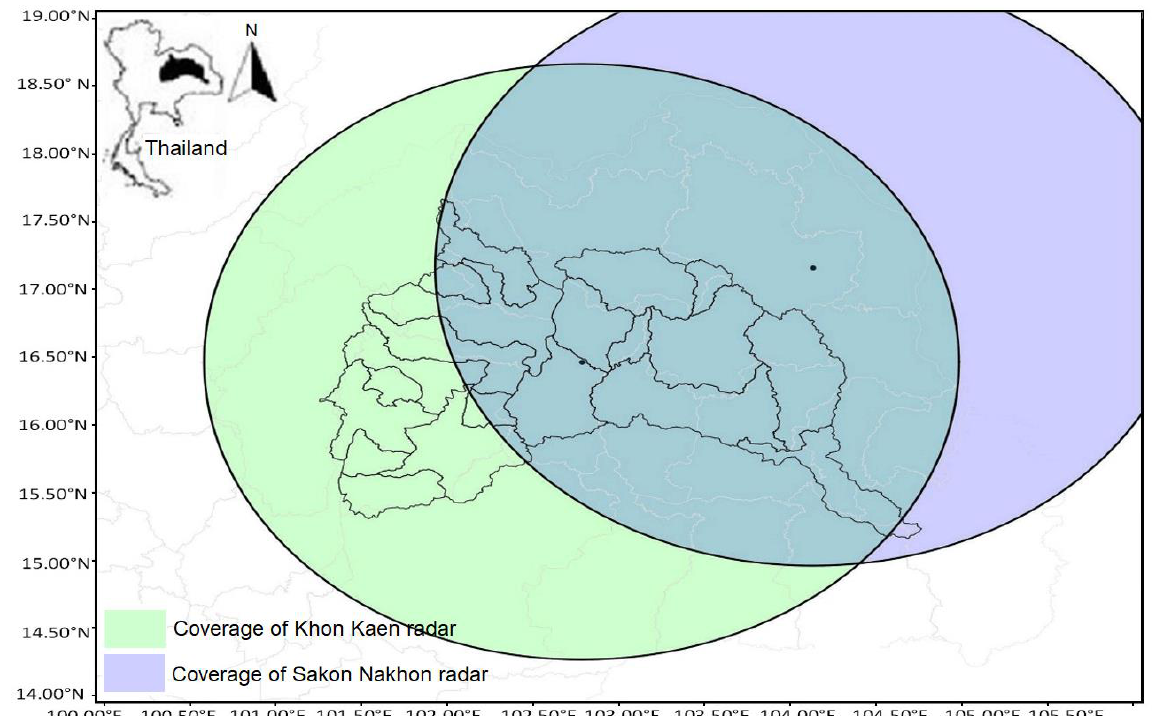
Figure 2. Coverage of Khon Kaen radar (green) and Sakon – Nakhon radar (purple) over the Chi Basin, showing the overlap between the two radars. Dots mark the center of the coverage where the radars are located.